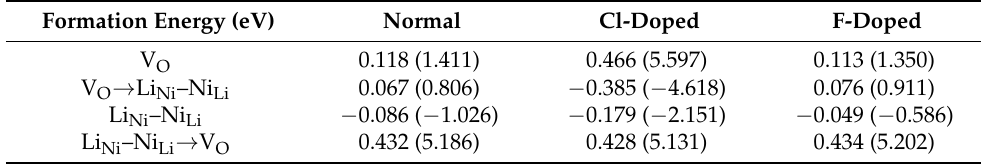
Table 4. Formation energy of typical defects in delithiation state.